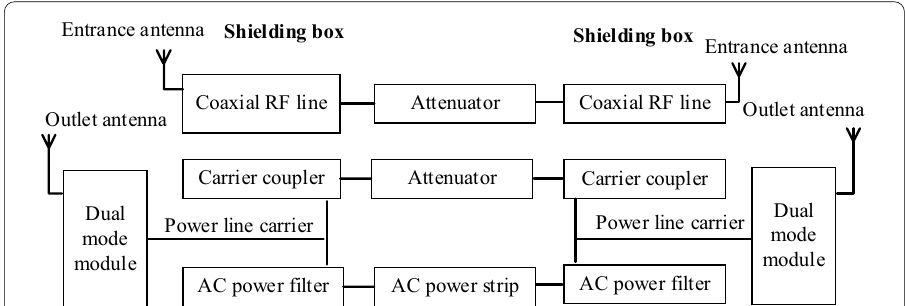
Fig. 8 Topology diagram of platform in laboratory